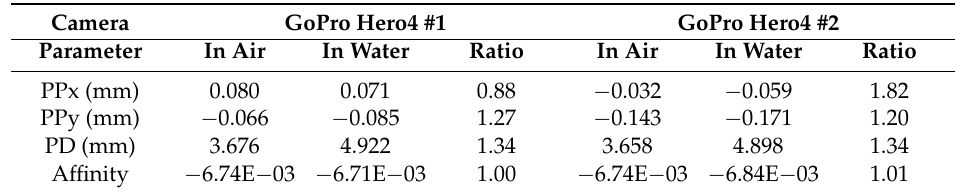
Table 1. Comparison of parameters from in air and in water calibrations for two GoPro Hero4 camera used in HD video